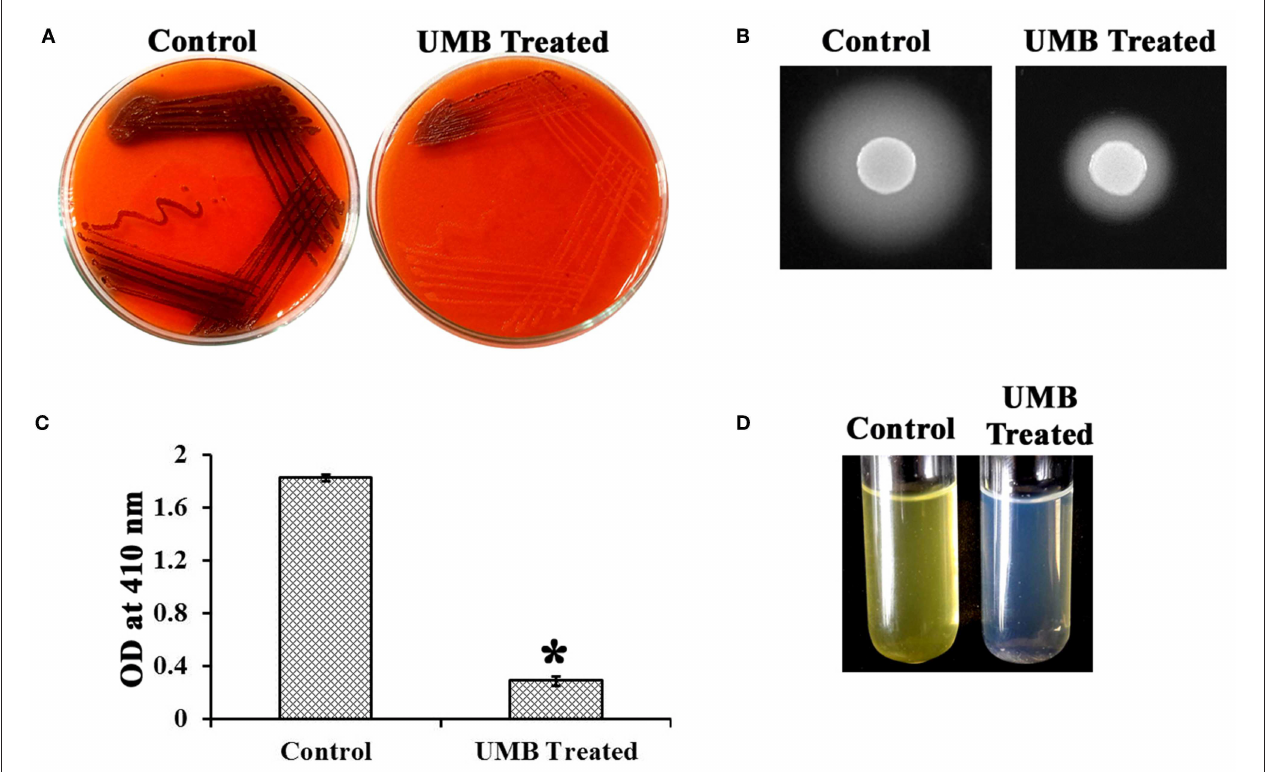
FIGURE 5 | Effect of UMB on production of slime and secreted hydrolases. (A) CRA assay indicating the reduced slime production upon UMB treatment. (B) Caseinase assay depicting the reduced zone of protease production upon UMB treatment. (C) Bar graph depicting the reduction in lipase production of MRSE upon UMB treatment. (D) Representative image of test tubes showcasing the reduced yellow color development in UMB treated tube than that of control, implying the reduction in lipase production upon UMB treatment. * Statistical significance between control and treated samples from three independent experiments ( p < 0.005).